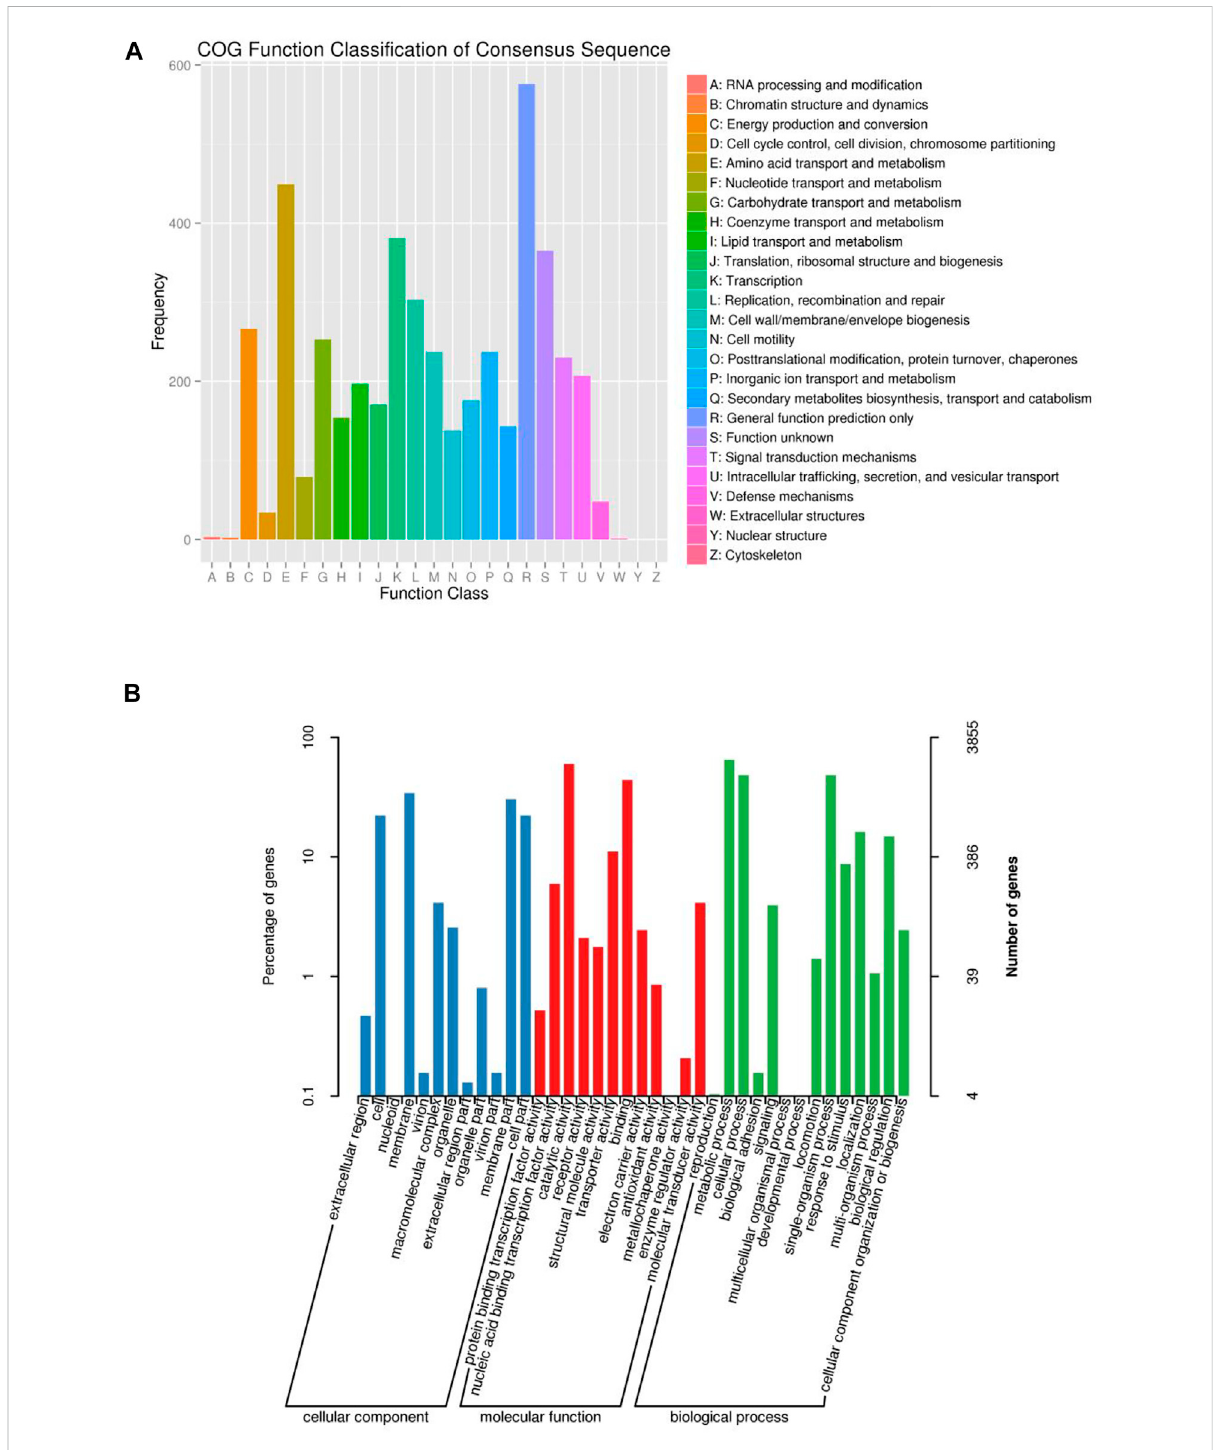
FIGURE 2 COGandGOfunctionalcategoriesofprotein-codinggenesinthe R.solanacearum FJ1003genome. (A) StatisticalresultsofCOGclassi fi cation; the abscissa indicates the content of COG classi fi cation; the ordinate is the number of genes. (B) Clustering results of GO annotation; the abscissa indicates the content of each GO classi fi cation; the left side of the ordinate indicates the percentage of the number of genes, and the right side indicates the number of